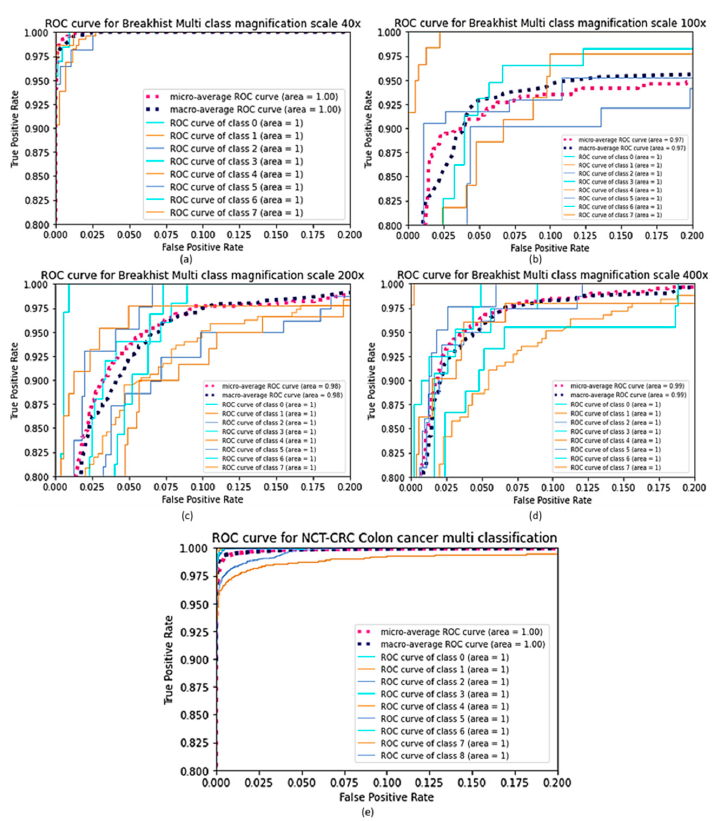
Figure 8. ROC curves of FabNet Model for multi classification, ( a ) 40 × magnification, ( b ) BreakHis 100 × magnification, ( c ) BreakHis 200 × magnification, ( d ) BreakHis 400 × magnification ( e ) ROC curves for NCT-CRC colon cancer dataset.